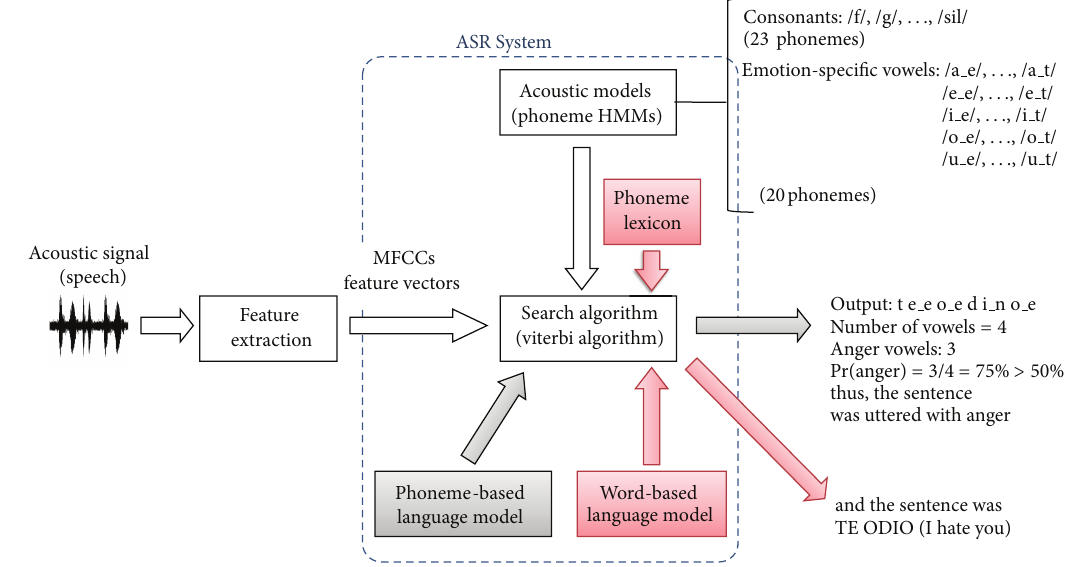
Figure 5: Structure of the ASR system for emotion